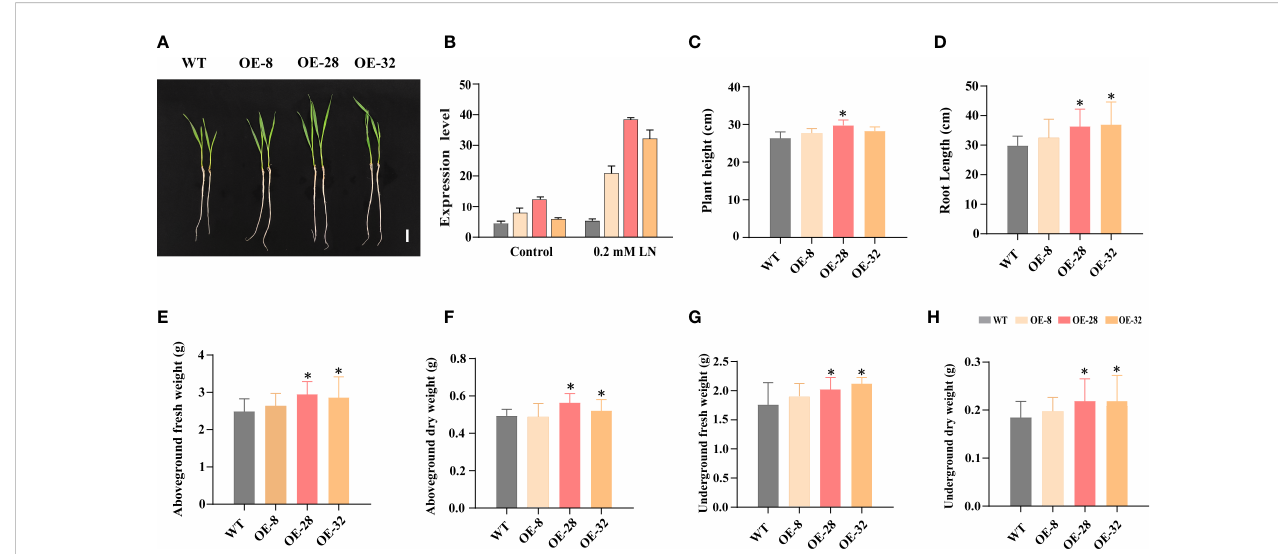
FIGURE 2 EdVP1 overexpression in wheat seedlings enhances low nitrogen stress tolerance (A) Phenotypes of the WT (SHI366) and transgenic EdVP1- overexpressing wheat lines OE-8, OE-28, and OE-32 grown under 0.2 mM low nitrogen (0.2 mM NO − 3 ) conditions. Scale bars = 5 cm. (B) EdVP1 expression in seedling roots of WT and T 3 transgenic EdVP1- overexpressing wheat lines grown under 0.2 mM NO − 3 and normal conditions. (C) Plant height, (D) root length, (E) aboveground fresh weight, (F) aboveground dry weight, (G) underground fresh weight, and (H) underground dry weight of WT (SHI366) and the transgenic EdVP1- overexpressing wheat lines OE-8, OE-28, OE-32 grown under 0.2 mM low nitrogen condition. Data represent mean ± standard deviation (n = 5), (* p < 0.05, Duncan ’ s multiple range